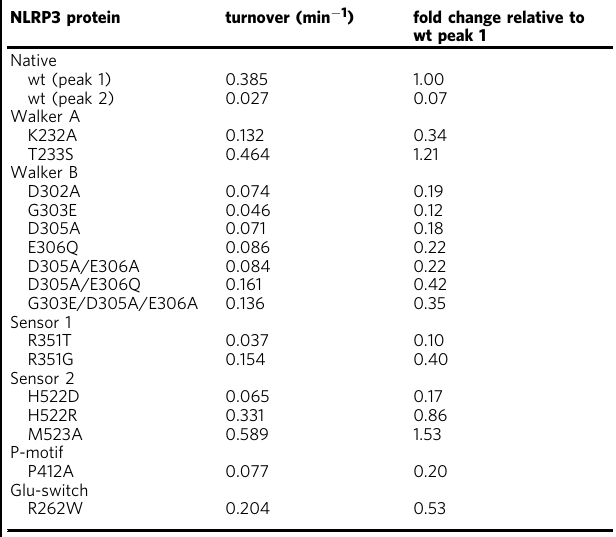
TheATP-hydrolysisreaction offulllengthMBP-NLRP3andprotein mutants(alwayspeak1)was analyzed over time by RP-HPLC using 3 µ M NLRP3 protein, 100 µ M ATP and 5mM Mg 2 + at 25°C.For wildtype NLRP3,peak 2 was also measuredunder the sameconditions. Theresulting turnover numbers (min − 1 ) derived from the initial linear part of the curves are